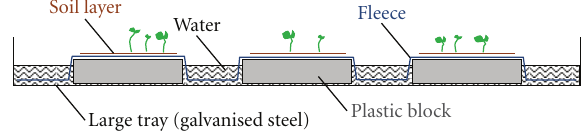
Figure 1: Details of the technical facility for seed germination to ensure constant moisture conditions. The large tray was 50cm × 70cm in size and the plastic blocks were each 20 cm ×